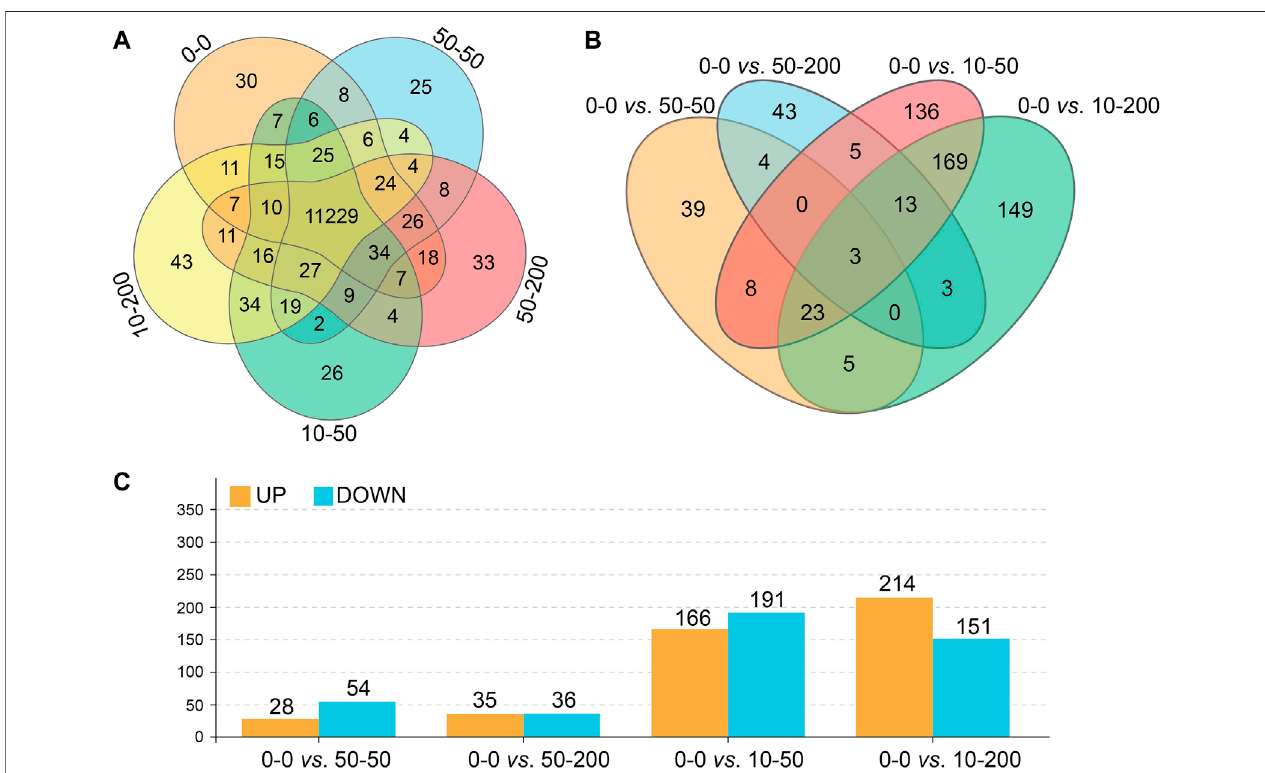
FIGURE 6 | Effect of surface topology on cell transcriptome. (A) Total number of gene expressions. (B) Differential gene number analysis. (C) Up- and downregulation numbers of differential genes.